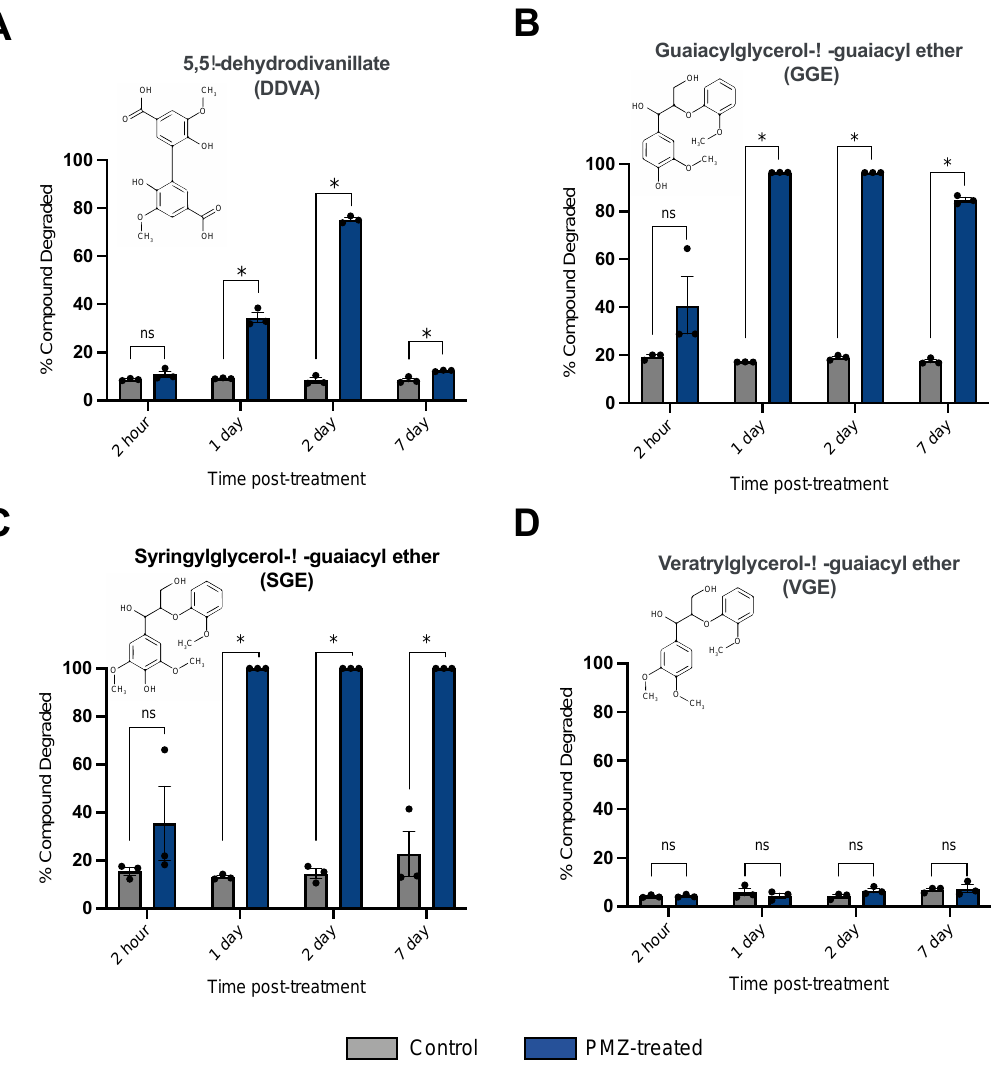
Figure 3. Functional assays of promethazine-induced P. radiata secretomes on dimeric lignin model compounds. Secretomes of P. radiata were collected at 2 h, 1 day, 2 days, and 7 days after promethazine treatment and then individually tested for the ability to degrade the dimeric lignin model compounds ( A ) 5,5′-dehydrodivanillate (DDVA) , ( B ) guaiacylglycerol-β-guaiacyl ether (GGE) , ( C ) sy- ringylglycerol-β-guaiacyl ether (SGE) , and ( D ) veratrylglycerol-β-guaiacyl ether (VGE) . The lignin model compounds were incubated with P. radiata secretomes for 3 days at 25 °C, and then measured for degradation using HPLC peak-height calculations. Bars represent mean of 3 biological replicates,